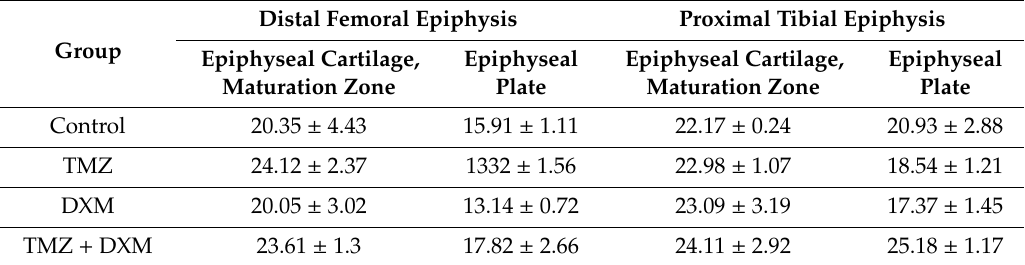
Table 1. The number of chondrocytes per unit area of the Wistar rat knee joint cartilage, units / ( µ M 2